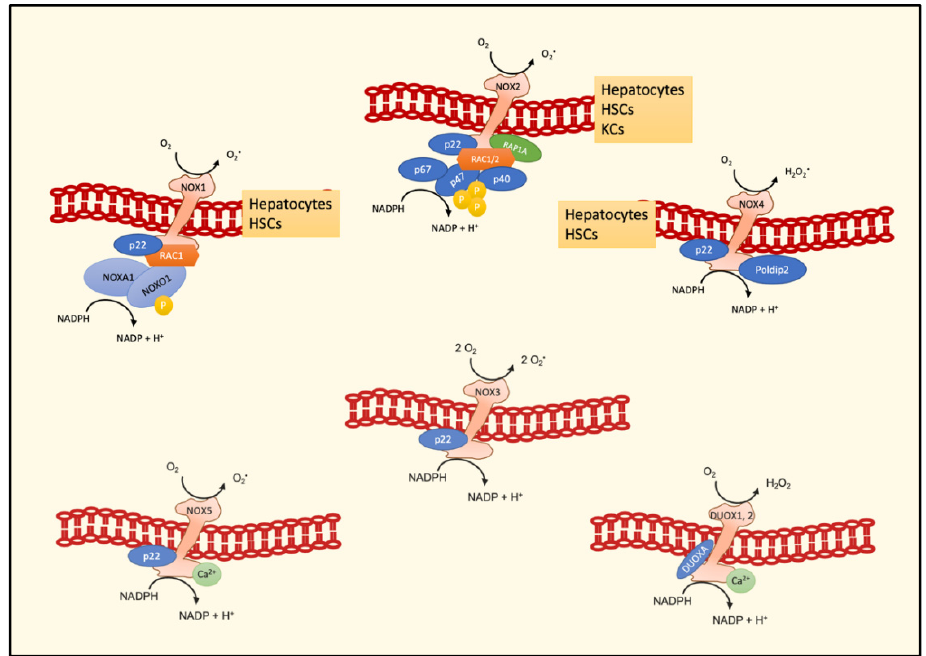
Figure 2. Schematic representation of subunits forming different NOX active enzymes and their main localization in hepatic cell types. Abbreviations: NADPH oxidase, NOX; hepatic stellate cells, HSCs; Kupffer cells, KCs.